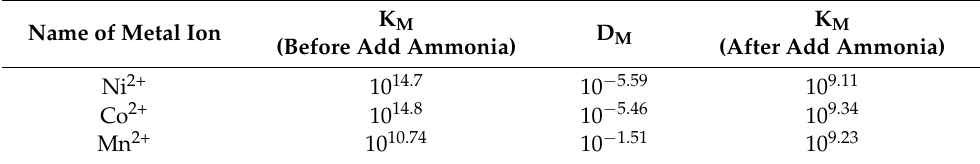
Table 1. Ni 2+ , Co 2+ and Mn 2+ before and after the addition ammonia of K M